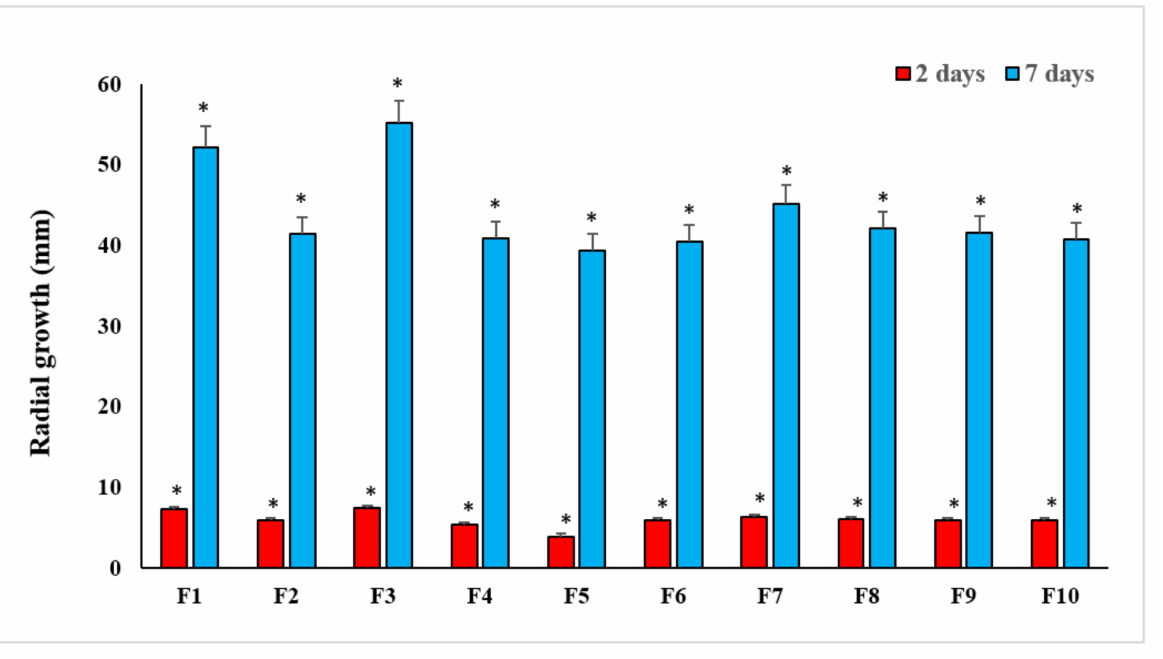
Figure 1. Radial growth of FOL isolates growing on a PDA medium at 25 ◦ C (highly significant = * p < 0.05, n =